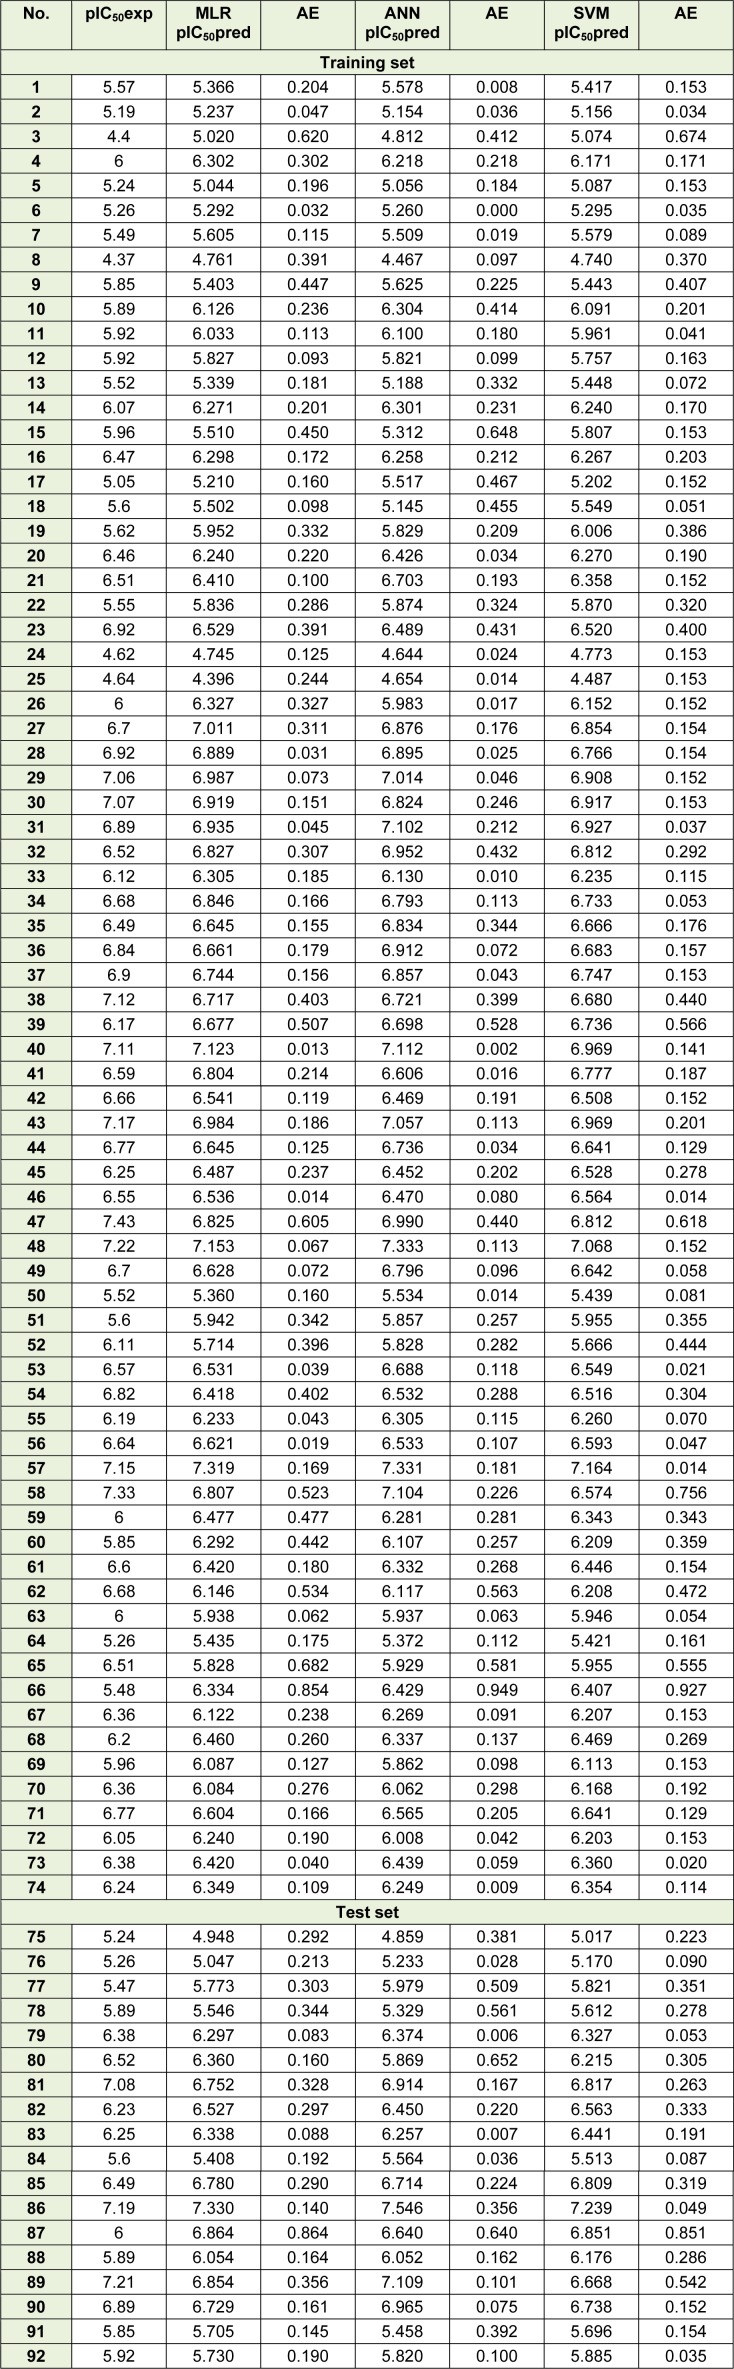
Experimental (exp) pIC50, predicted (pred) IC50 and absolute error (AE) values of 74 training and 18 test set compounds